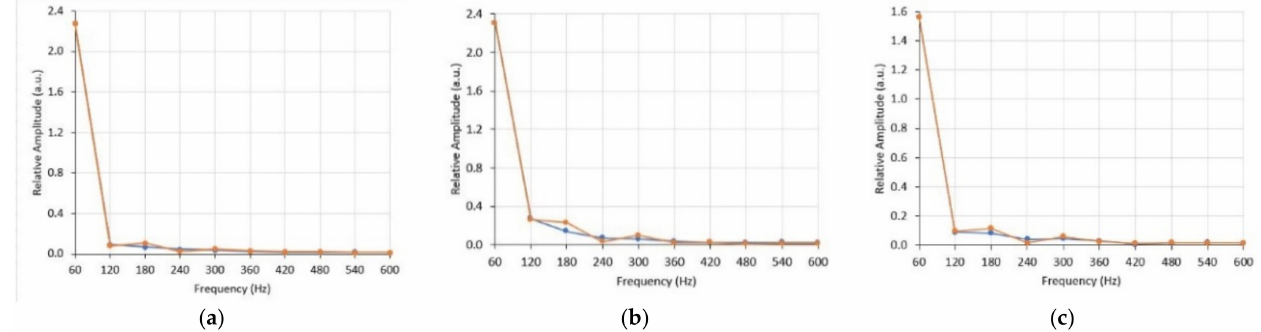
Figure 13. FFT of sag ( a ), swell ( b ) and interruption ( c ) disturbances, with the input (blue line) and output (red line) superimposed.